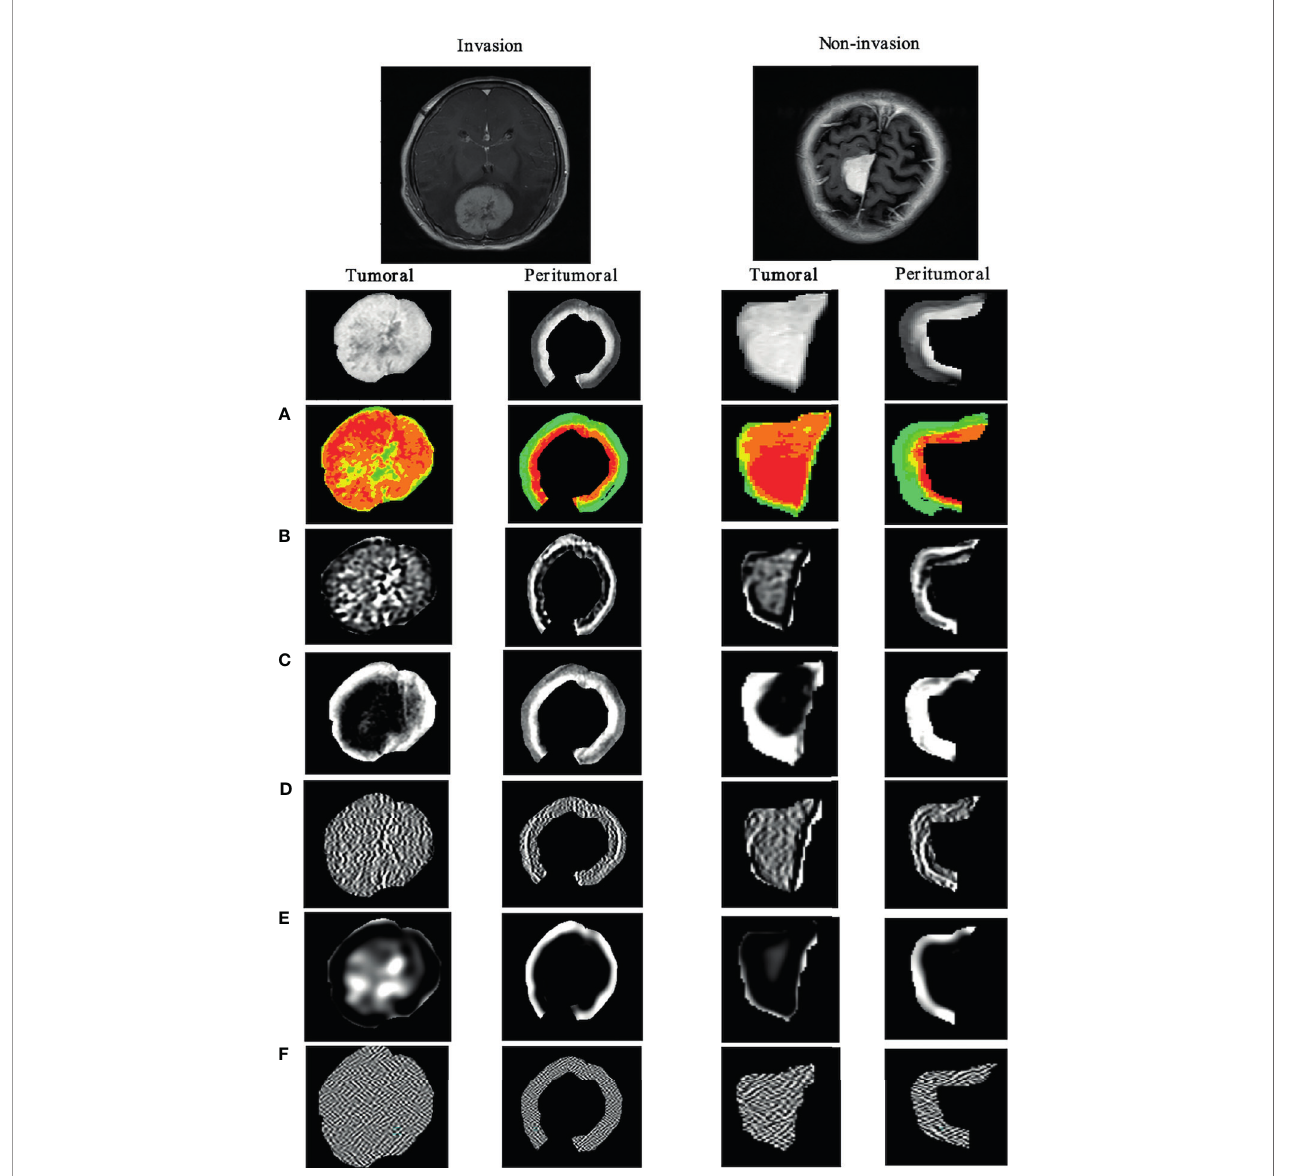
FIGURE 5 | Visualization of tumoral and tumor-to-brain interface signi fi cant radiomics features of brain invasion and non-invasion in patients with meningioma. The results show the differences between two ROIs in the high-throughput radiomics features. In meningioma with brain invasion, the signal in the tumor is more dense, and the texture signal intensity around the 5-mm tumor is higher, that is, the information complexity is higher. (A) Original_ fi rstorder (pseudo-color image); (B) wavelet-LLH_gldm; (C) log-sigma-1-0-mm-_glcm; (D) lbp-m2_ngtdm; (E) log-sigma-3-0-mm-_glrlm; (F) wavelet-HHL_glszm. ROI, region of